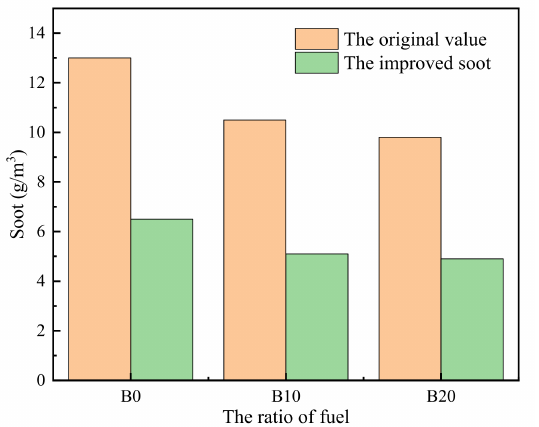
Figure 10. Comparison between the improved soot and the original value under 75% load.